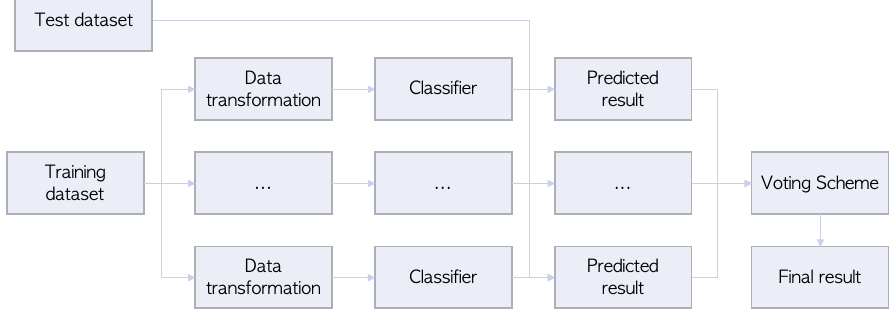
Figure 4. Framework for ensemble AI [97].